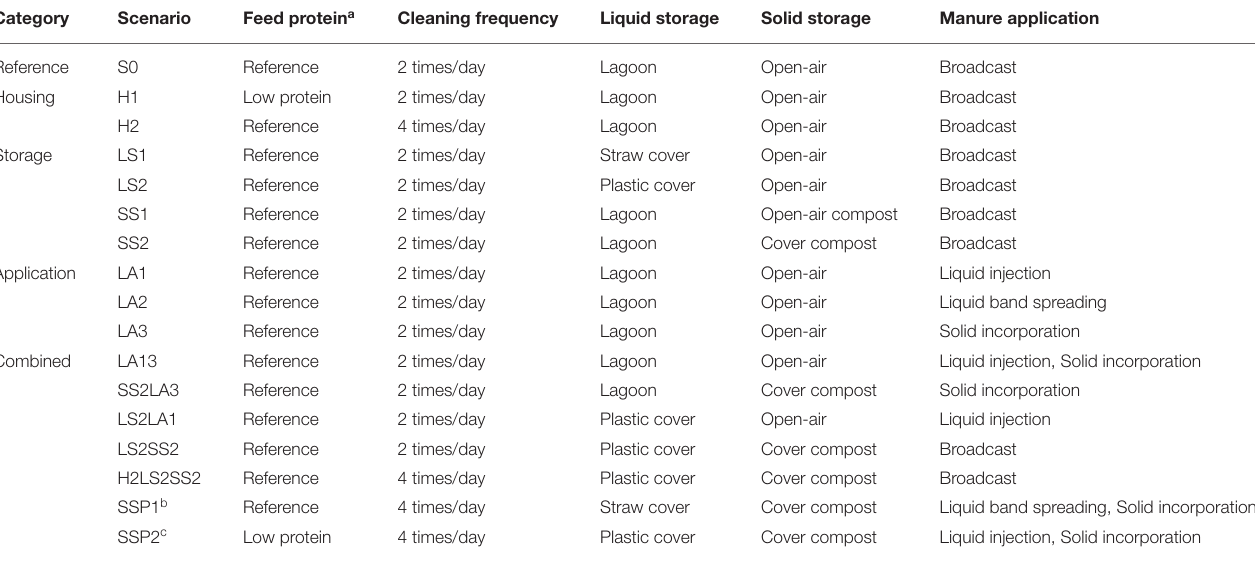
TABLE 2 | Scenarios of manure management chain in agriculture and husbandry combined